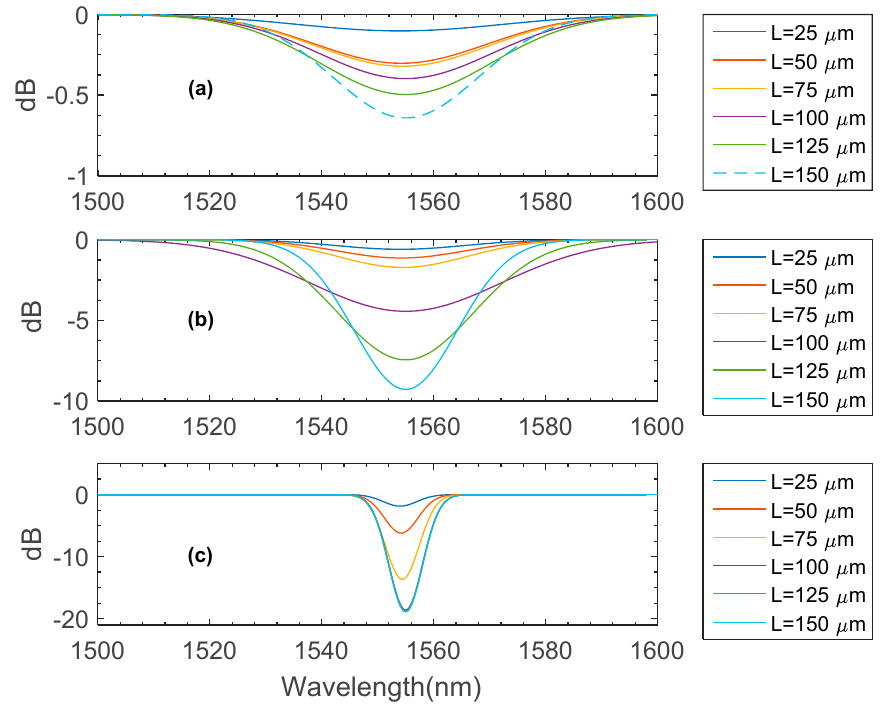
Figure 12. The numerically acquired spectrum for various grating lengths; the grating period is 435 μ m. The numbers of periods in ( a ), ( b ), and ( c ) are 15, 30, and 42 respectively.